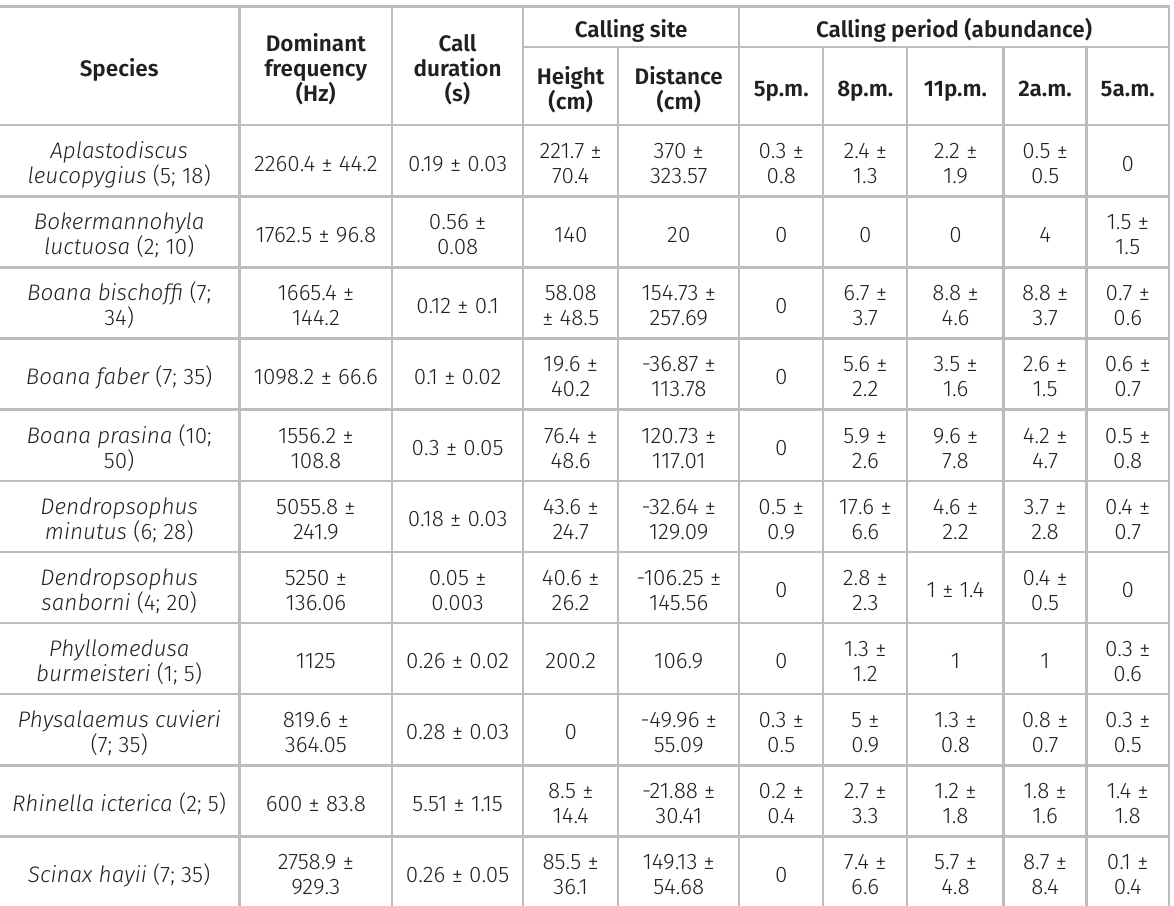
Table I. Three different dimensions of reproductive niche for 11 species of anuran amphibians in a permanent pond in Reserva Biológica Municipal da Serra do Japi ( RBMSJ ), Jundiaí municipality, São Paulo State, Brazil. Species (number of males; number of notes analyzed), mean (± SD) of dominant frequency (in Hertz), call duration (in seconds), height from the ground and distance from the margin of calling site (in centimeters) and mean abundance (± SD) of estimated males calling in each period of daily